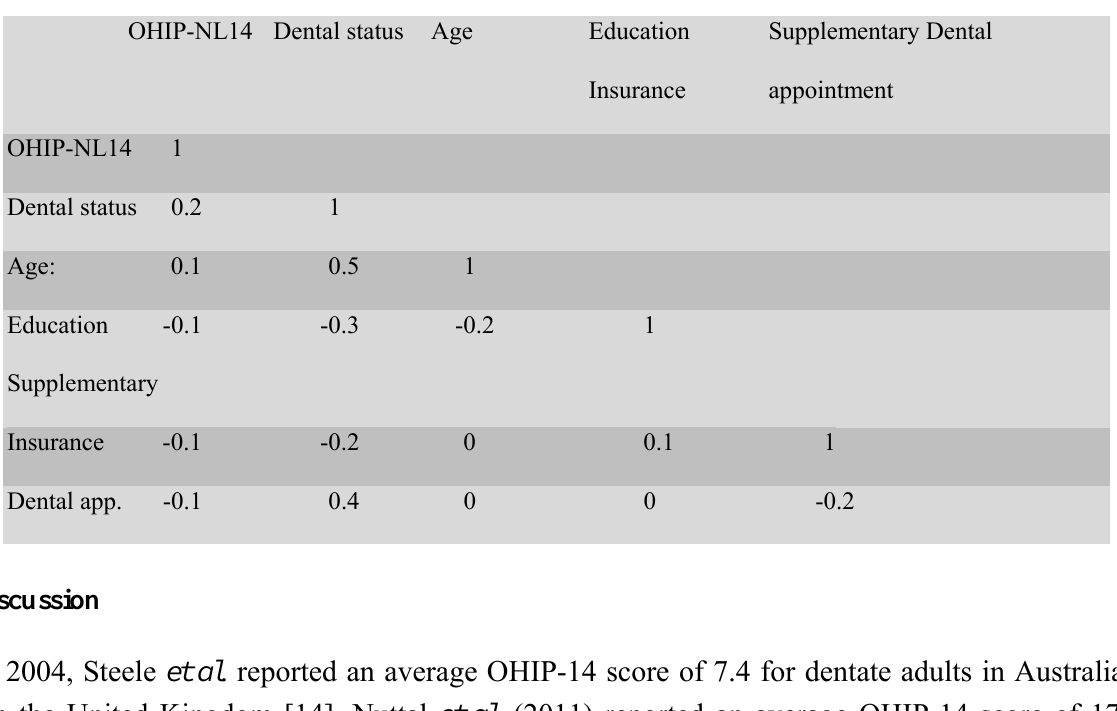
Table 2. Shows the Pearson correlations between all study variables. Correlation matrix OHIP-NL14 and study variables